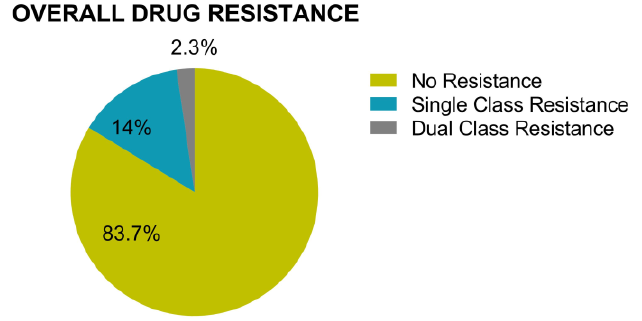
Figure 10. Prevalence of multi-drug resistance, assessed in 86 participants for whom both protease-RT and integrase genotyping was successful. Of the 12 individuals (14%) with single class resistance, 10 had NNRTI resistance, 1 had NRTI resistance, 1 had INSTI resistance. Two cases of dual-class resistance were to NRTI/NNRTI and NRTI/INSTI, respectively.